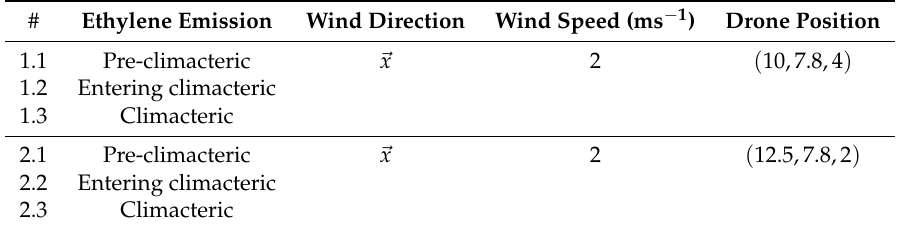
Table 1. Summary of drone simulator runs. The simulation number (#) will be used as a reference for naming each of these scenarios in the following sections.